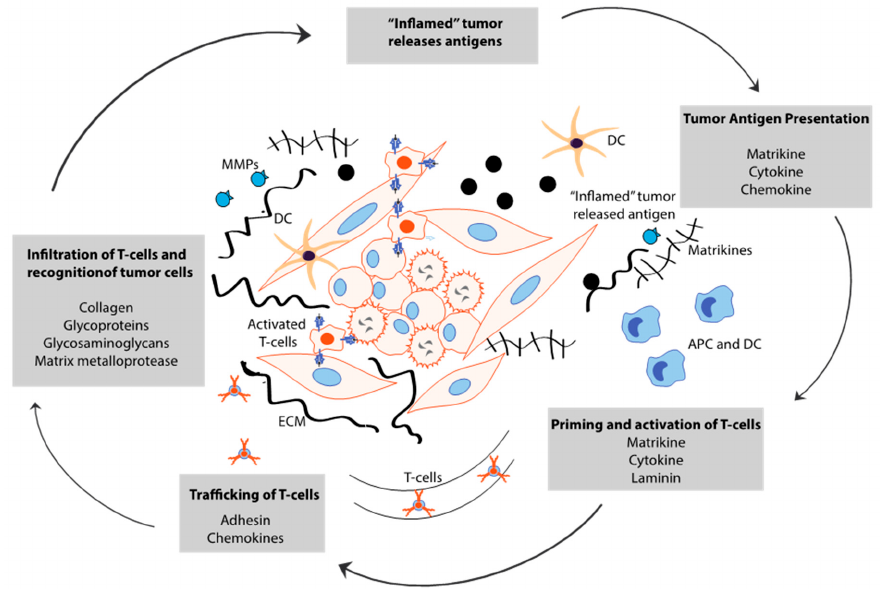
Figure 3. Role of the ECM in modulating the tumor immune microenvironment: Matrix remodeling shapes the inflamed immune microenvironment. “Inflamed” tumor releases the antigens that are used for antigen presentation. The ECM components are processed by the metalloproteases to release matrikines (versikine) which in turn regulate the priming and activation of T cells. ECM also serves as a sca ff old for T cell migration by